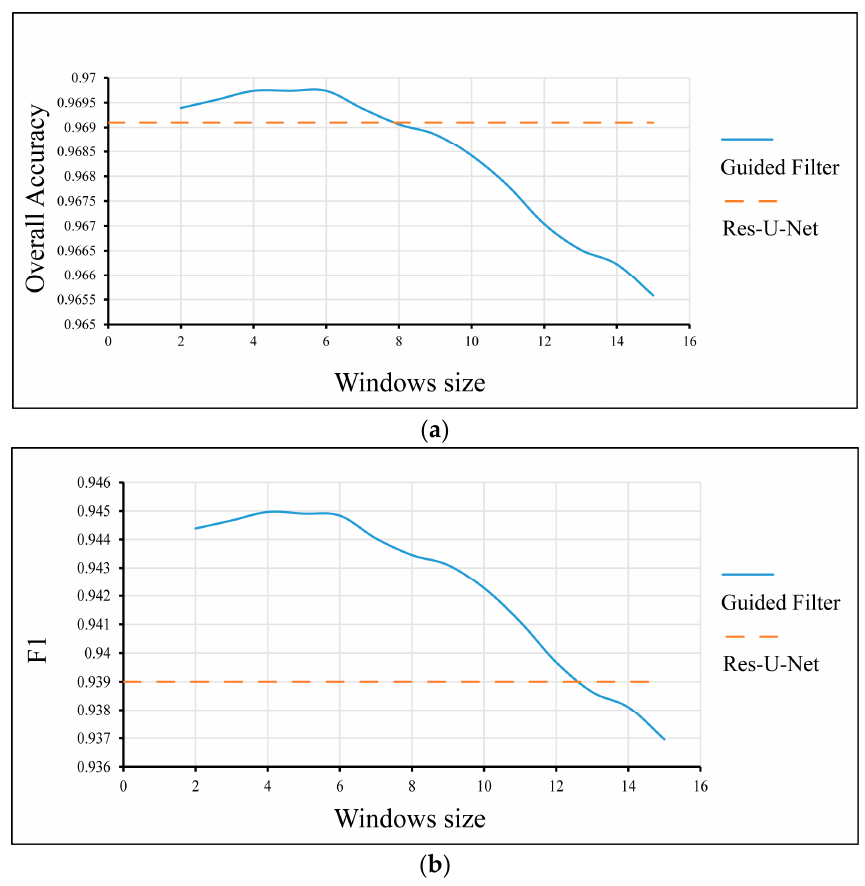
Figure 13. The overall accuracy ( a ) and F 1 ( b ) changing as the size of window increases while optimization by the guided filter .